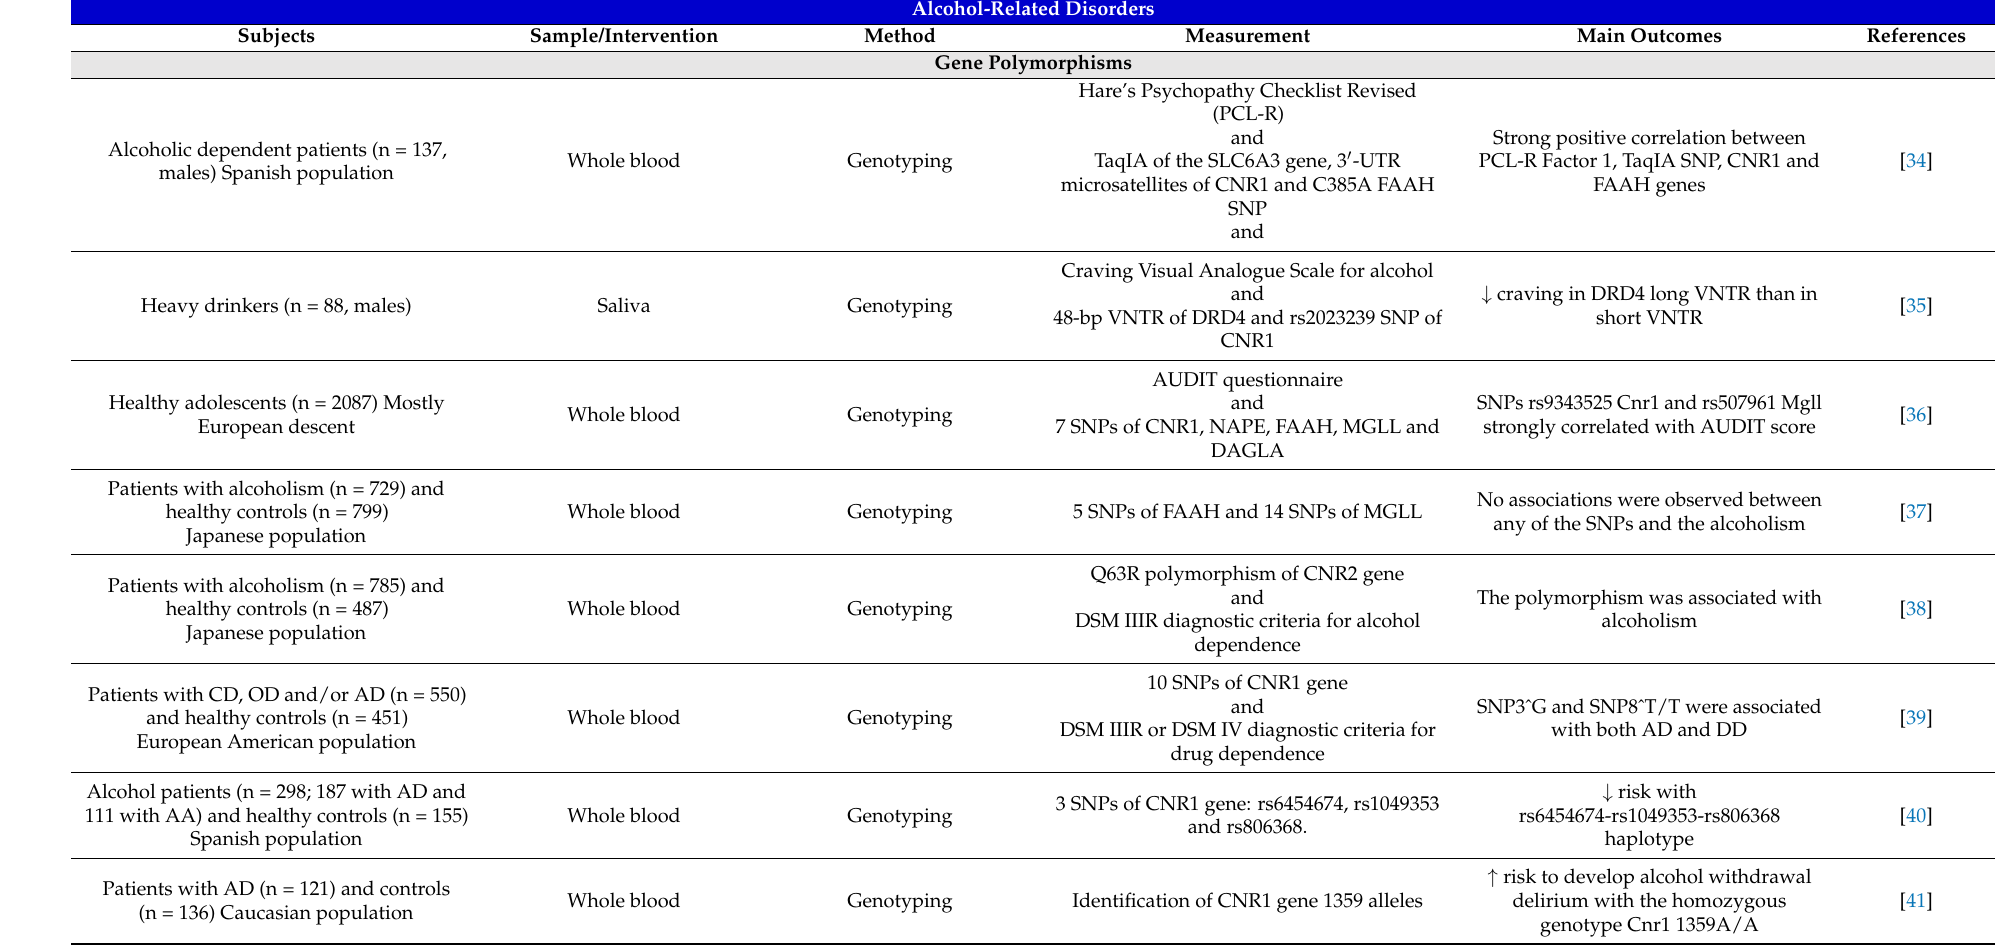
Table 1. Main findings from human and animal studies aimed to identify alterations of ECS components in alcohol-related